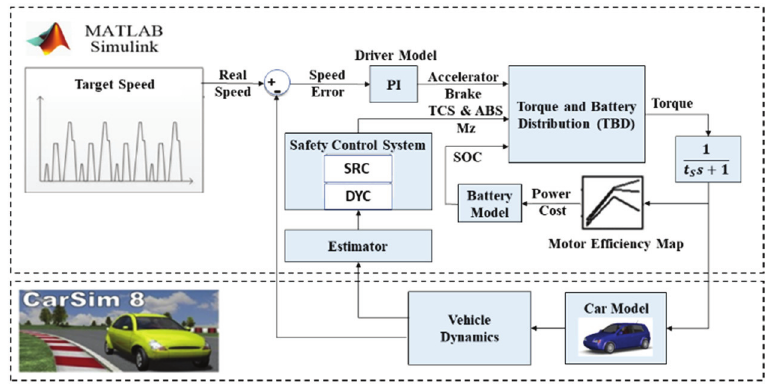
Figure 5. Simulation block diagram of torque and battery distribution strategy.